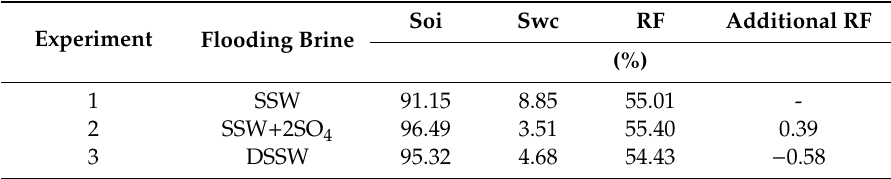
Table 12. Summary of real structure water-wet micromodel with initial oil saturation, connate water saturation and final oil recovery factors.